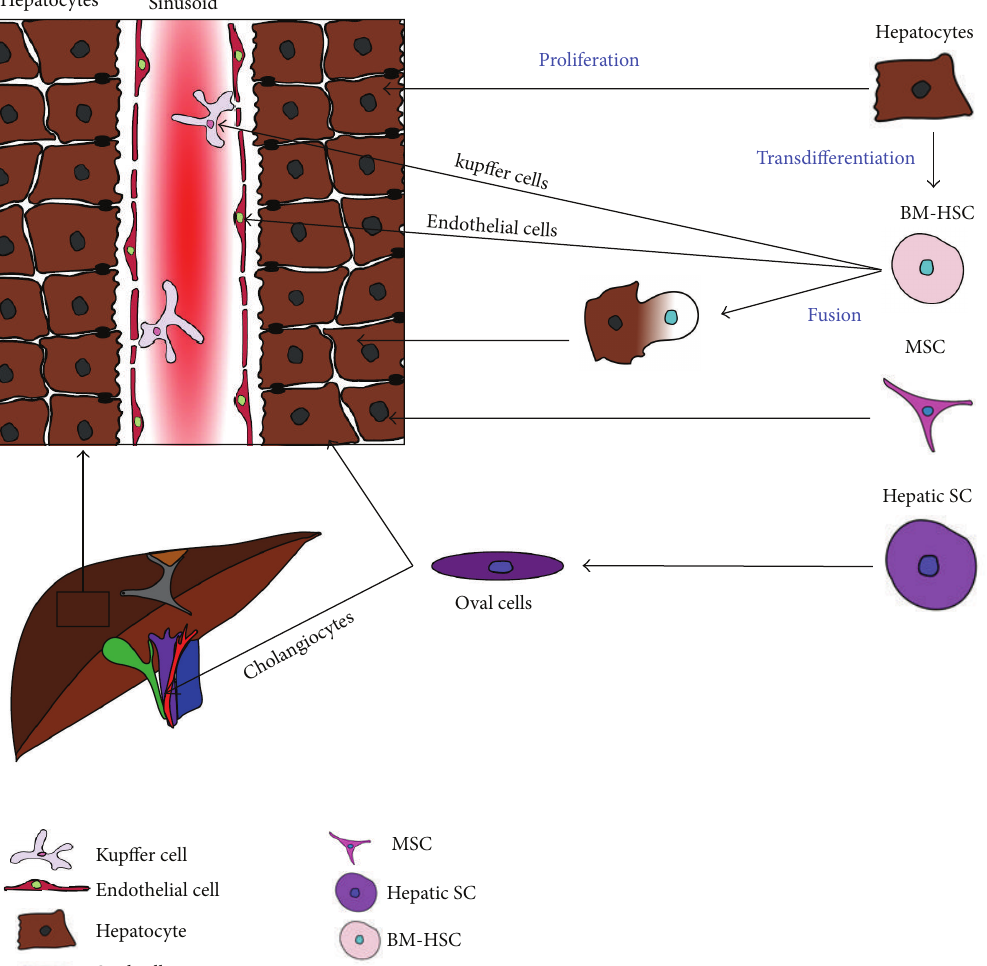
Figure 1: Cell sources for hepatocyte regeneration. Liver regeneration was suggested to result from proliferation, trans differentiation, and cell fusion, involving intrahepatic (hepatic SC, oval cells, and mature hepatocytes) and extrahepatic (BM-HSC, MSC) cell sources. BM-HSC: bone marrow derived hematopoietic stem cell, hepatic SC: hepatic stem cell, MSC: mesenchymal stem cell.